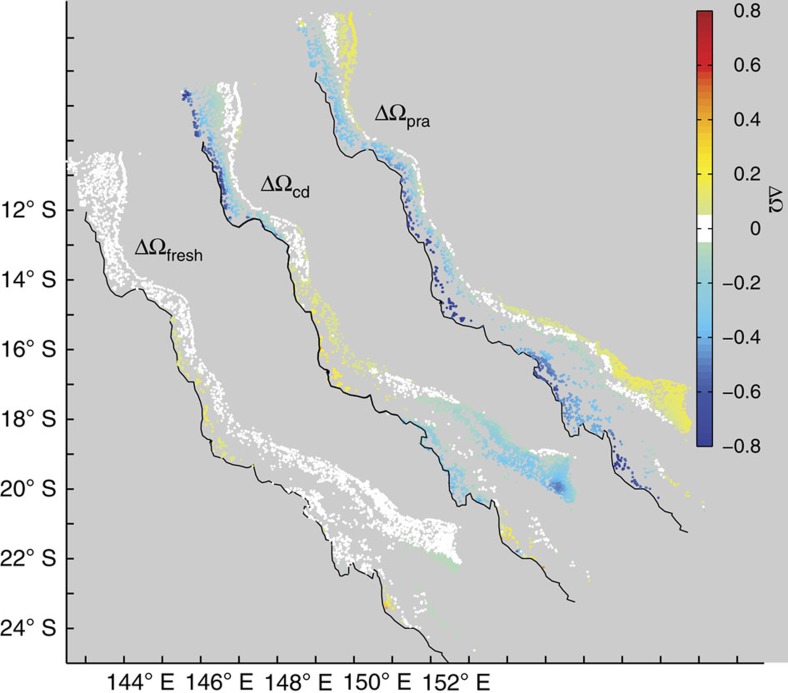
Drivers of change in aragonite saturation.The changes are separated into the affect due to hydrological cycle (ΔΩfresh; left), net calcification (ΔΩcd; centre), and due to the combination of photosynthesis, respiration and air–sea exchange (ΔΩpra; right), average from daily September 2010–September 2012 values.